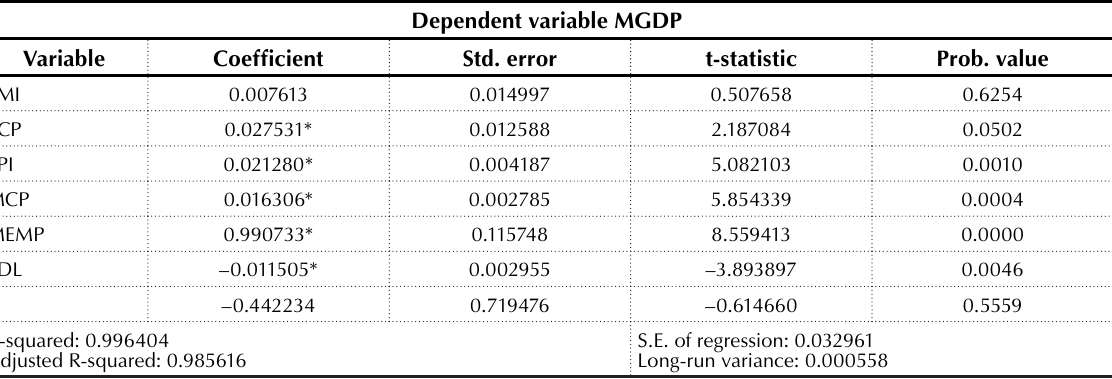
Source: Authors’ calculation from Eviews